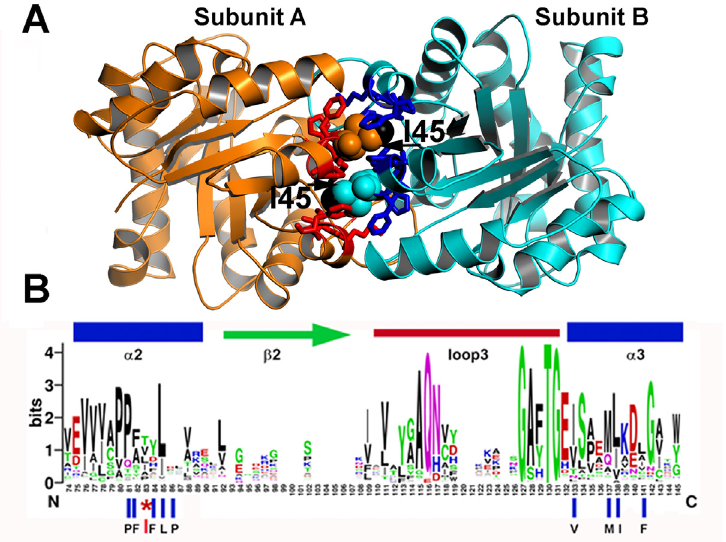
Fig 1. Ball and socket interaction between monomers at TvTIM1. (A) Crystal structure of TvTIM1 showing the ball and socket interplay. Hydrophobic TvTIM1 residues (ball-stick representation) form a socket that interacts with residue Ile45 of the neighboring subunit (space-filling representation). The methyl group of I45 is colored in black. (B) Sequence logo showing the structural alignment of the ball-socket amino acids at the ball and socket interplay Residue I45 or V45 functions as the ball and a hydrophobic cavity formed by α - helices 2 and 3 that assemble as the